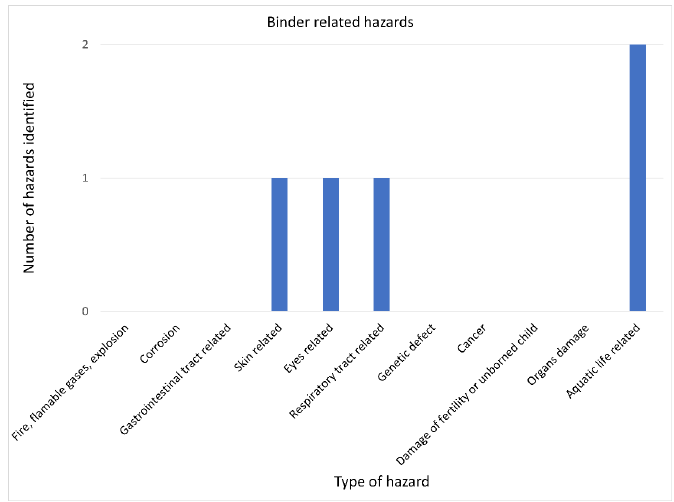
Figure 10. The number of the hazards identified versus the type of hazard for current collector materials in Mg–S cells. Similarly, in the case of the anode materials, it can be noticed that only a few materials are used for the binders accompanied with cathode materials in Mg–S batteries. Such binder materials pose only a few hazards associated with their use.